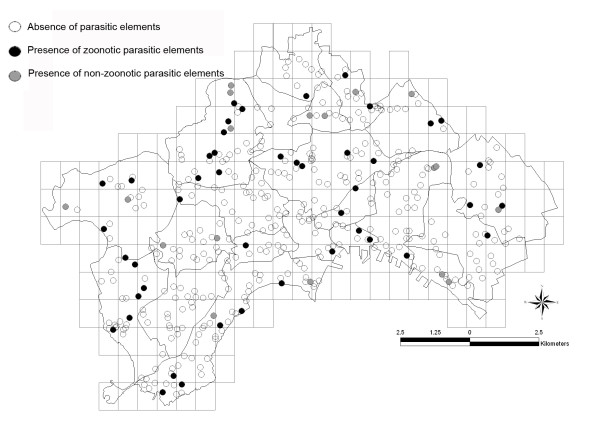
Occurrence of canine faecalization in the city of Naples, Italy, February–May, 2005. Location of negative (white) and positive (black and grey) samples for parasitic elements.